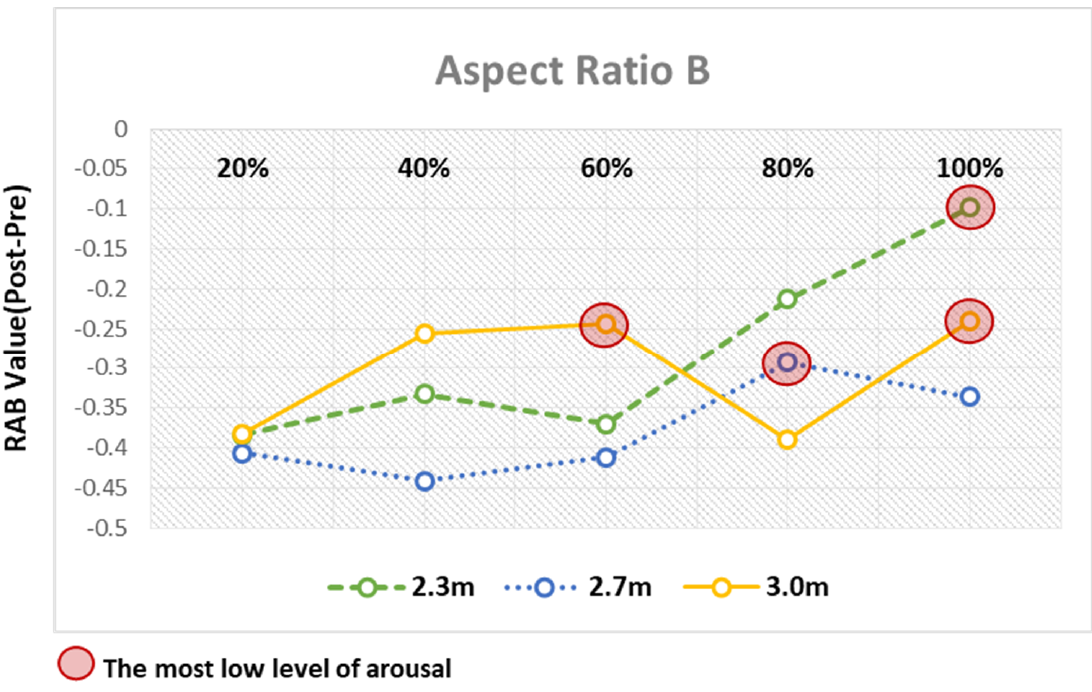
Figure 14. Analysis of arousal levels based on aspect ratio B.